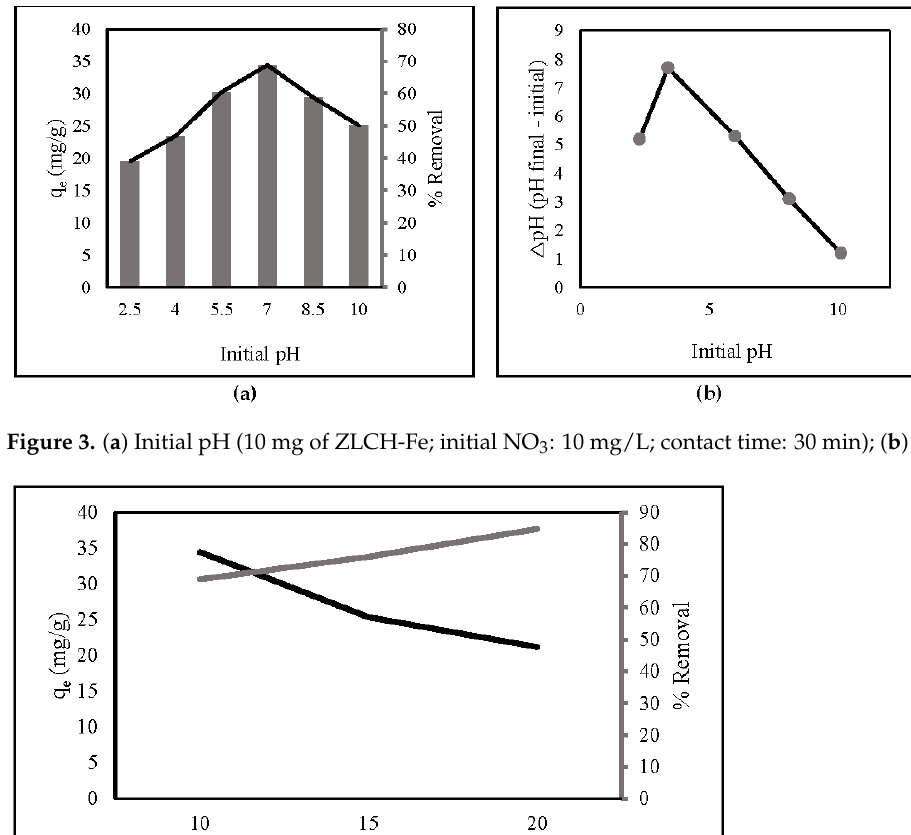
Figure 3. ( a ) Initial pH (10 mg of ZLCH-Fe; initial NO 3 : 10 mg/L; contact time: 30 min); ( b ) pH zpc.